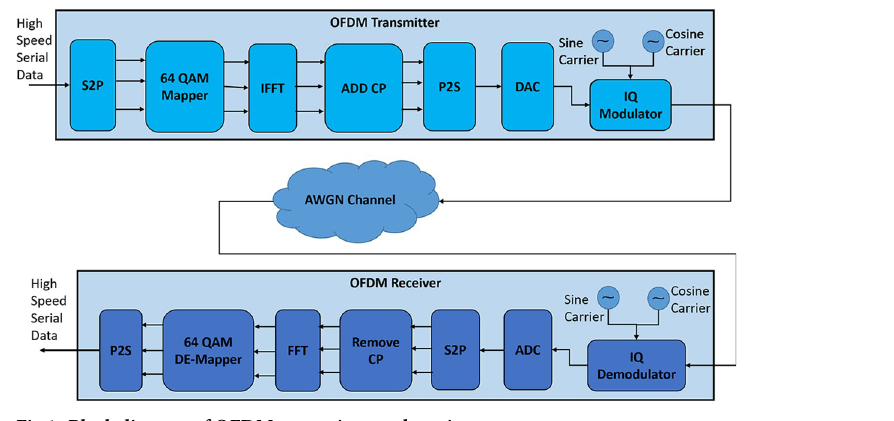
Fig 1. Block diagram of OFDM transmitter and